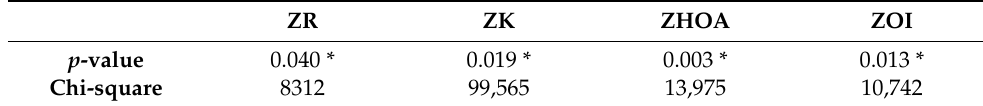
Table 4. Representation of the p -values for the categories satisfaction-back (ZR), satisfaction-body (ZK), satisfaction-the hips and outer thighs (ZHOA), satisfaction-inner thighs (ZOI), of the BODY-Q questionnaire and according to the breakdown into the weight loss groups; * The correlation is significant at the 0.05 level.